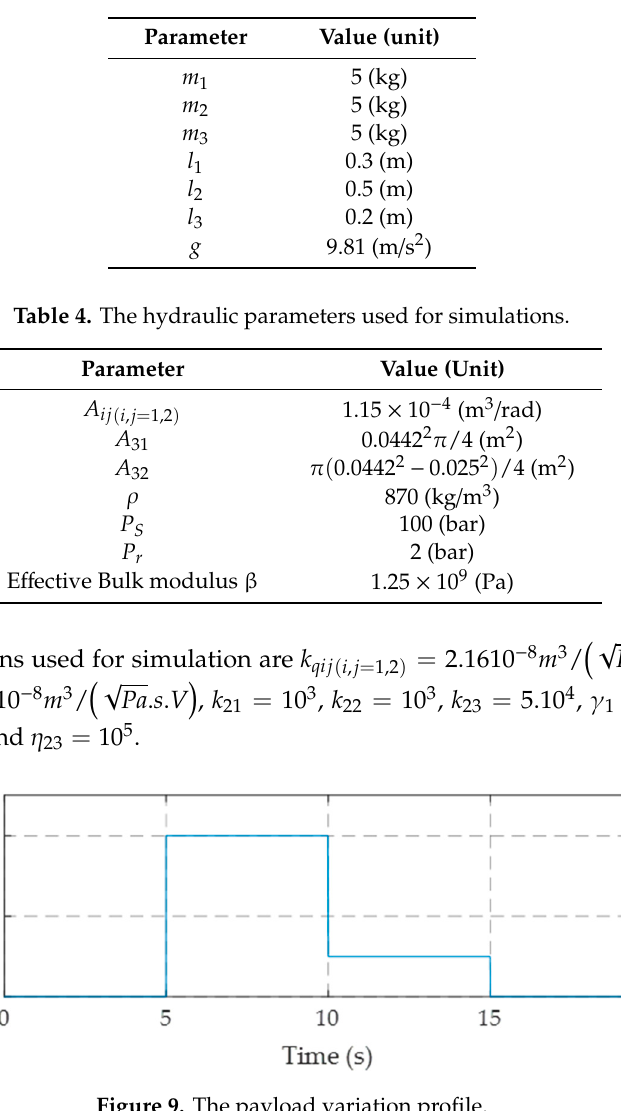
Table 3. The mechanical parameters used for simulations.